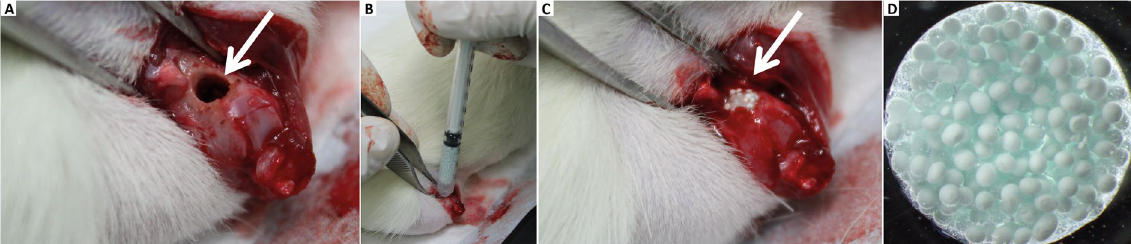
Figure 1. In vivo intraoperative setting. Critical sized defect created in the distal femur ( A ). Injection of the hybrid material using a 1 mL syringe ( B ) and filled defect ( C ). Detail of the hybrid system, composed of HAp microspheres embedded in a RGD-alginate hydrogel ( D